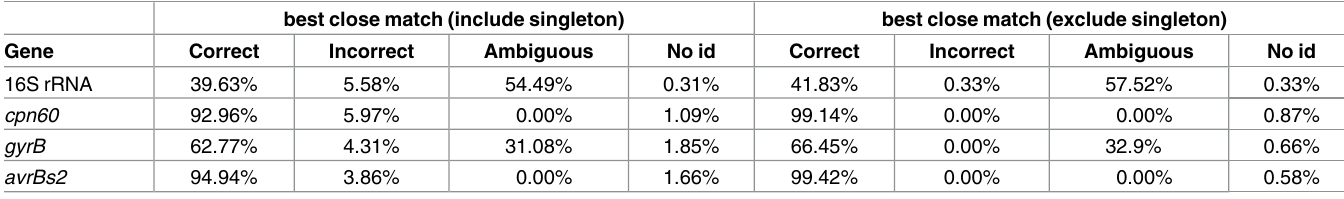
Table 3. Identification successbased on “best close match”